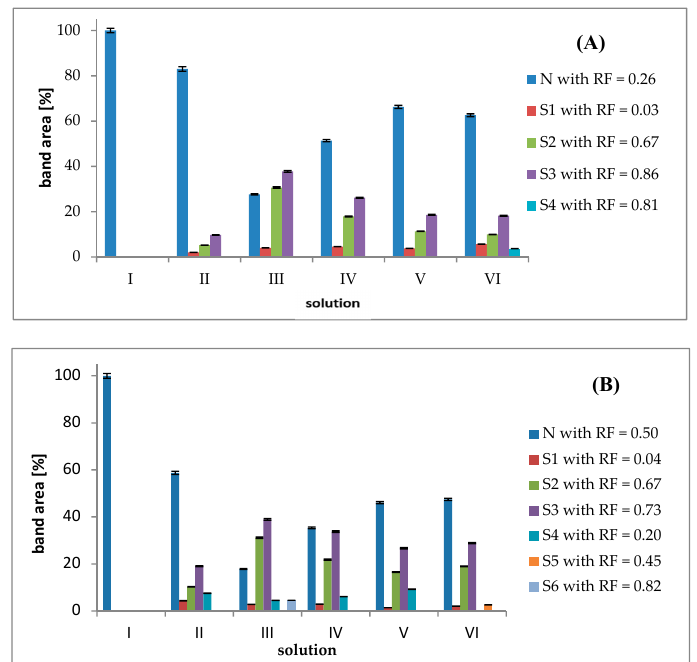
Figure 4B indicates that there were five chromatographic bands on the densitograms of